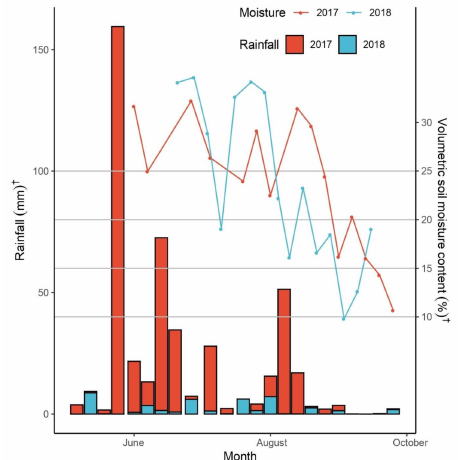
Figure 1. Rainfall (mm) and volumetric soil moisture content (%) situations at Shangzhuang Agricul- tural Research Station, Beijing, China for the study carried out consecutively in 2017 and 2018 from May to October. † Left and right axes have different